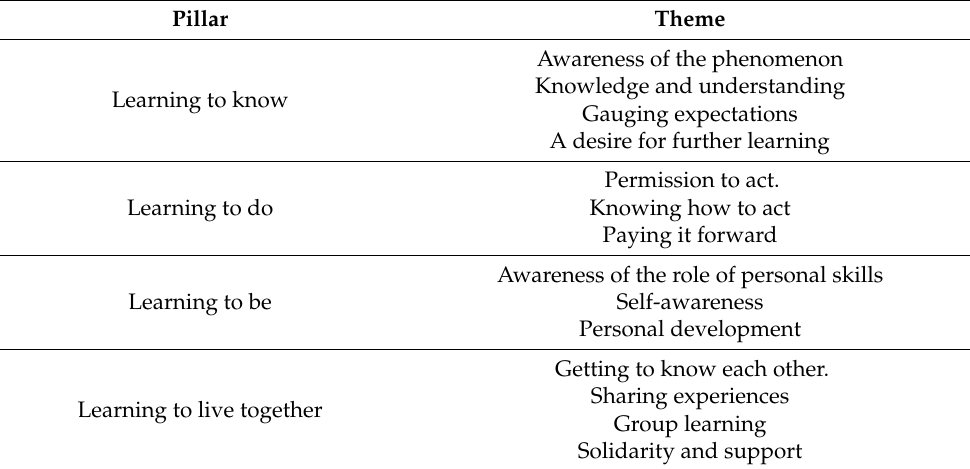
Table 1. Themes related to the four pillars of lifelong